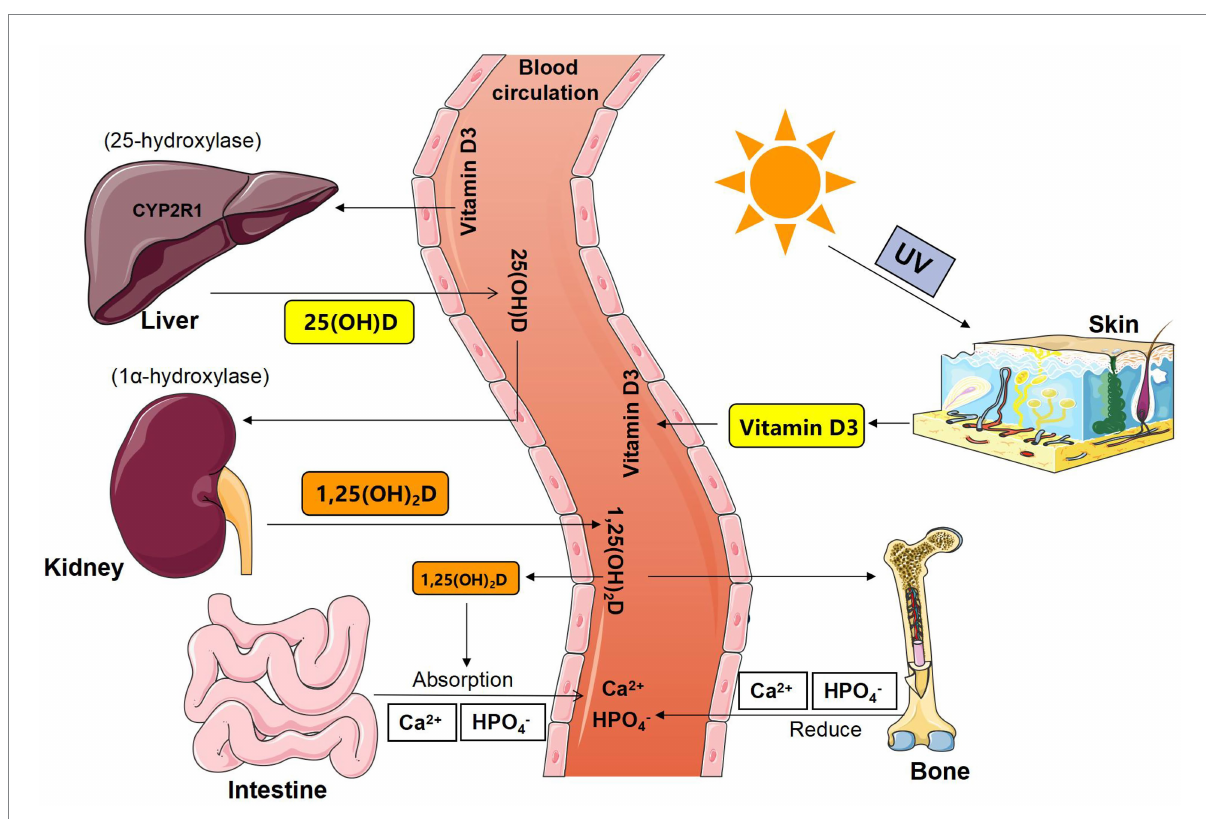
FIGURE 1 Schematic diagram of the synthesis and metabolism of vitamin D. 25 (OH) D = 25-hydroxyvitamin D; 1,25 (OH)2D = 1,25-dihydroxyvitamin D; 1 α -hydroxylase = CYP27B1, Cyto-chrome